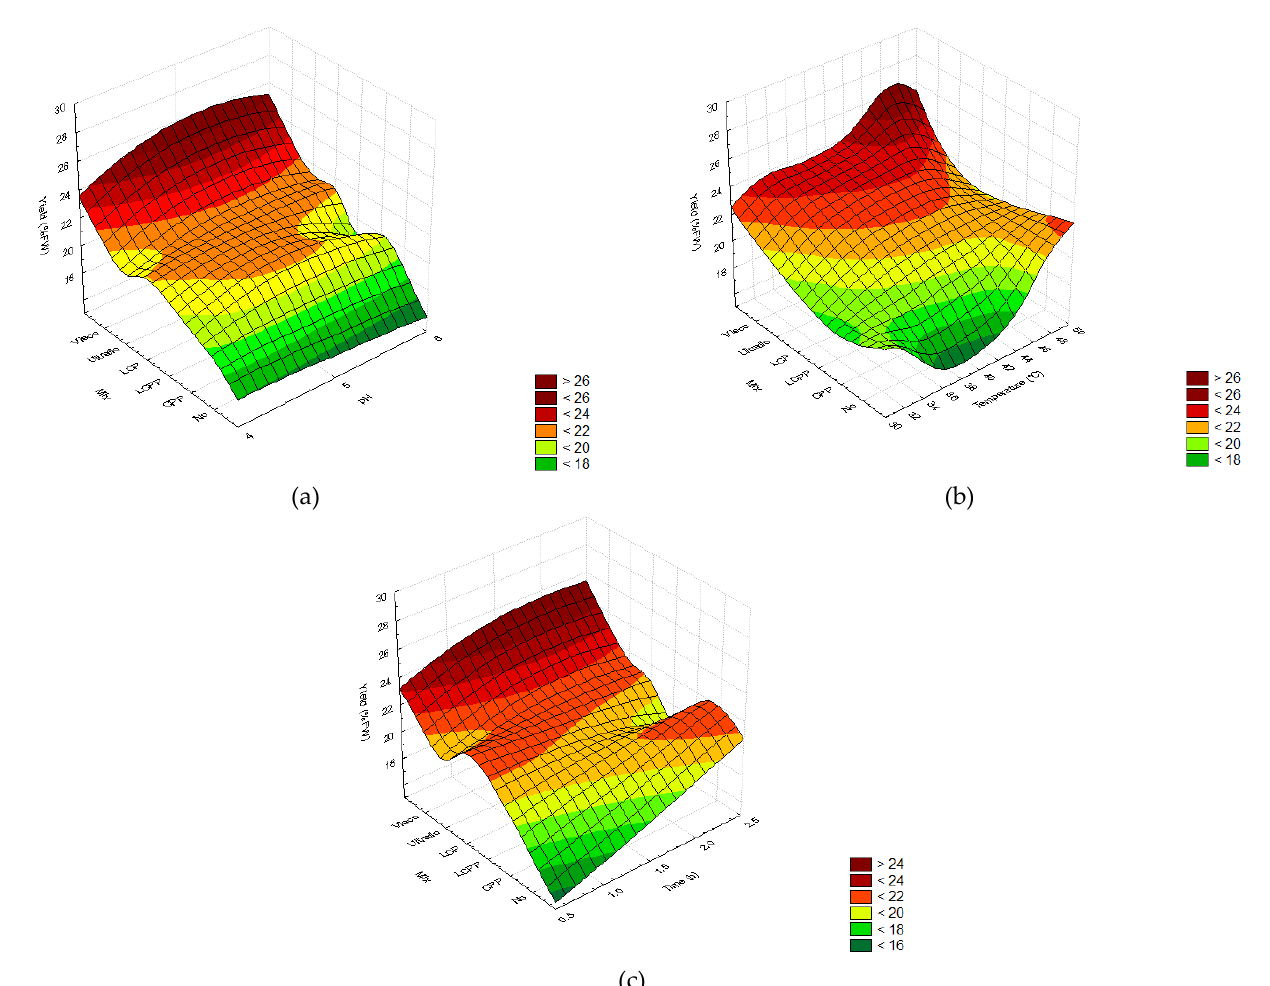
Figure 4. Extraction yields (%FW) plotted as a function of the different enzymatic mixes. ( a ) pH (4–6), ( b ) temperature (30–50 ◦ C), and ( c ) time (0.5–2.5 h). In order, two commercial cocktails: Viscozyme© (Visco) and Ultraflo© (Ultraflo); three formulated cocktails with laccase, cellulase, and pectinase at proportions of 1:1:1 (LCP), 1:1:2 (LCPP), and 0:1:2 (CPP); and the control without added enzymes (No). The color scale indicates the significance of the analysis of variance for the Taguchi method (n = 3, p >